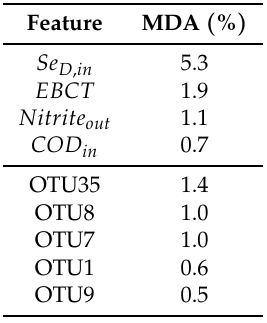
Table 7. MDA feature importances for Dirichlet clustering.